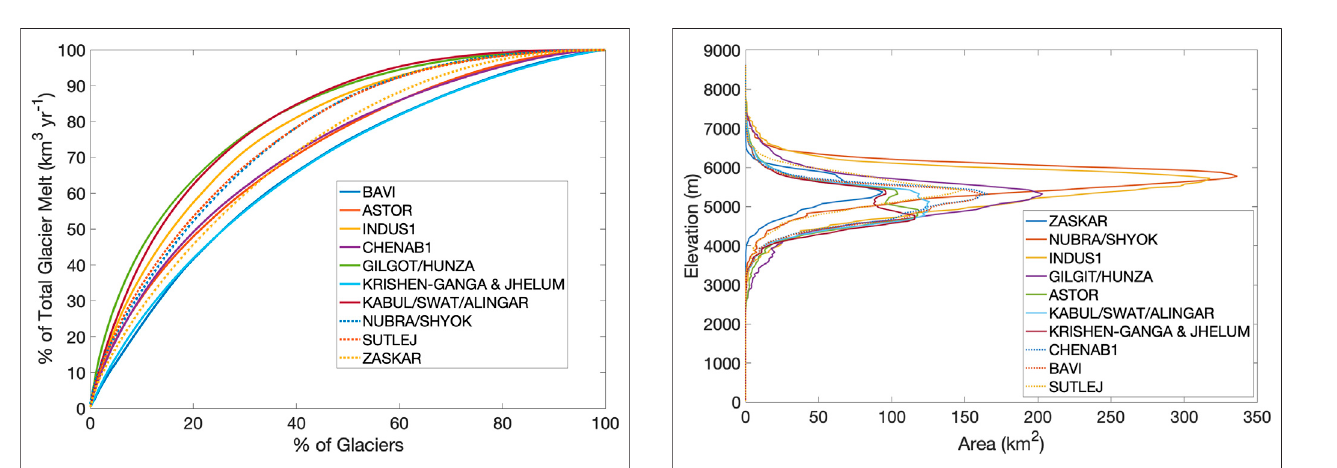
FIGURE 8 | Glaciers contributing to annual average melt (2001 – 2013), by subbasin. If each glacier produced the same amount of melt, there would be a 1:1 line. The logarithmic-shaped curves demonstrate that, by number, a minorityofglacierscontributethemajorityofmelt.Thosecontributingthe most melt are the biggest